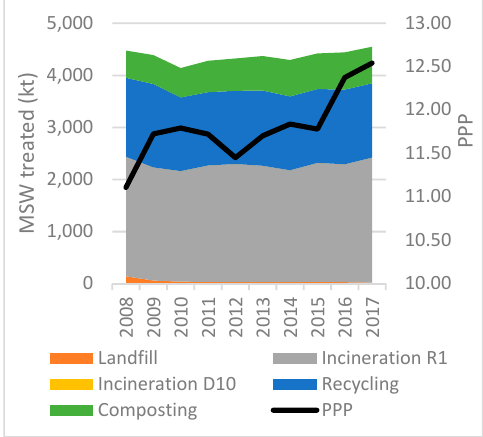
Figure 54. Waste treatment methods and PPP in Sweden 2008–2017 (EUROSTAT 2019b, 2019c).